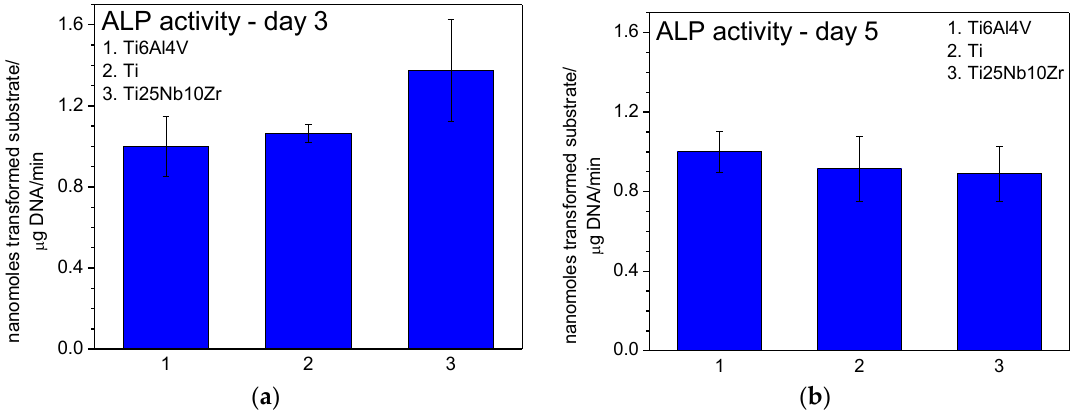
Figure 12. Alkaline phosphatase (ALP) activity in cells grown on the samples measured after 3 ( a ) and 5 ( b ) days of culture.